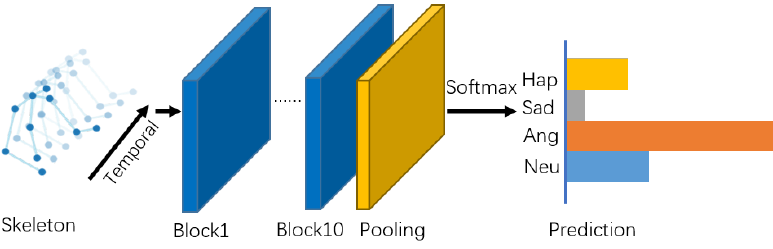
Figure 4. Overview of our proposed self-attention enhanced spatial temporal graph convolutional